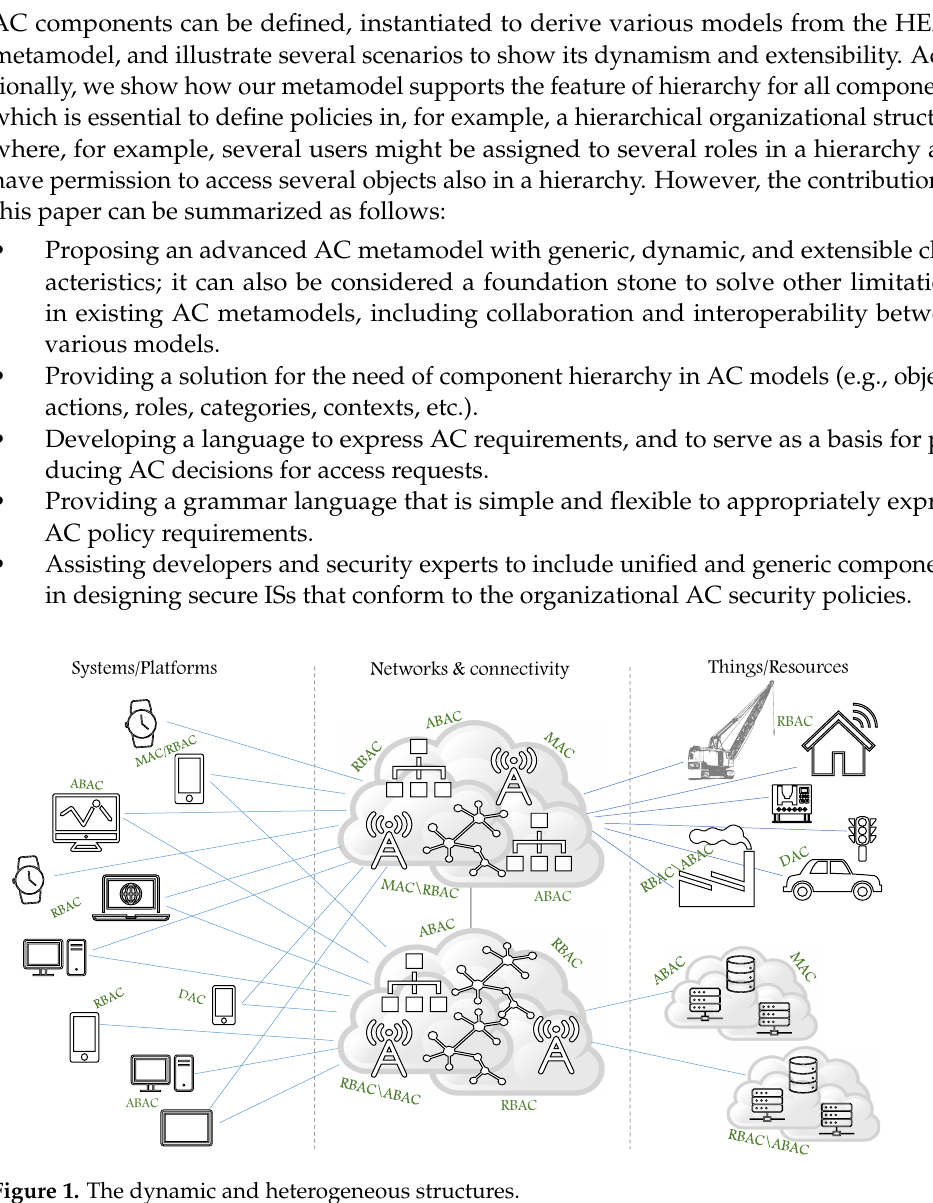
Figure 1. The dynamic and heterogeneous